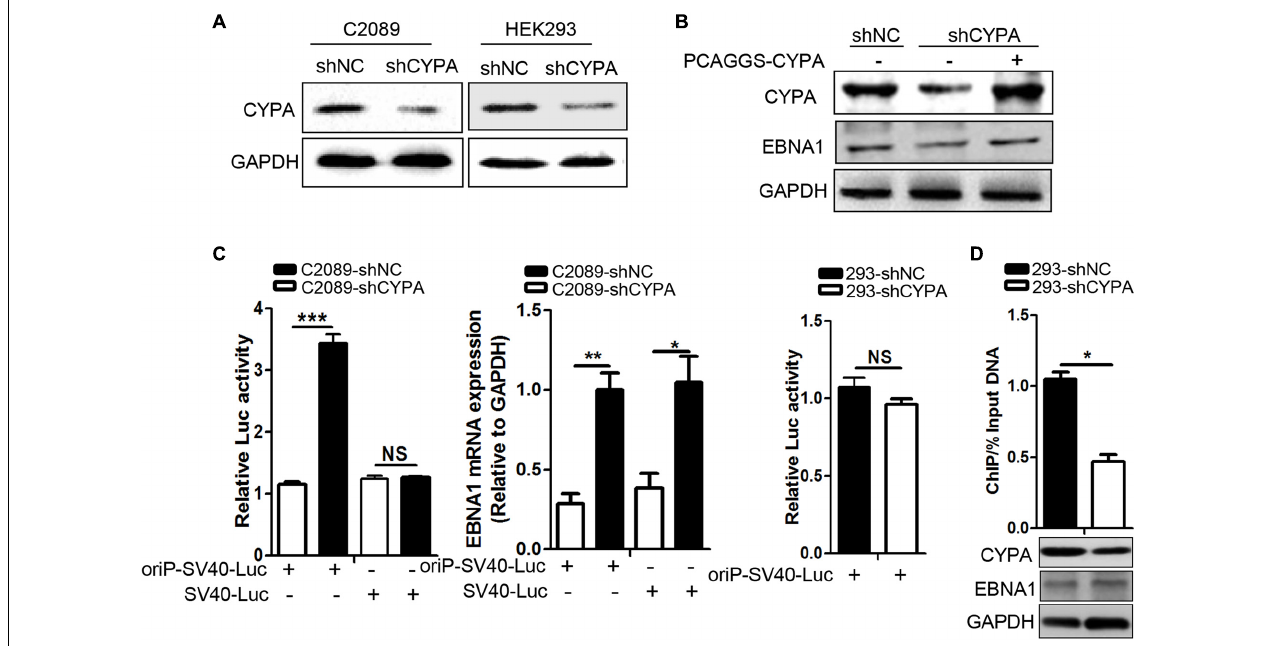
FIGURE 4 | The effect of CYPA knockdown on EBNA1–mediated oriP transcription activity. (A) The detection of CYPA expression in stably transfected cell lines with shRNA-CYPA and shRNA-NC. (B) Restoration of EBNA1 protein expression in C2089-shCYPA cells transfected with wild-type CYPA expression plasmids. CYPA and EBNA1 proteins were detected by WB. (C) Effect of CYPA knockdown on EBNA1-oriP-mediated transcription activity in the luciferase reporter assay. The EBNA1 mRNA was detected by RT-qPCR. (D) Effect of CYPA knockdown on binding of EBNA1 to oriP in the ChIP assay. CYPA was depleted from HEK293 with shRNA. Antibodies against Myc and IgG control were respectively used for the pulldown in ChIP assaysHEK293. The precipitation of oriP DNA was quantitated by RT-qPCR. CYPA and EBNA1 proteins were detected by WB. ∗ P < 0.05, ∗∗ P < 0.01, ∗∗∗ P < 0.001.